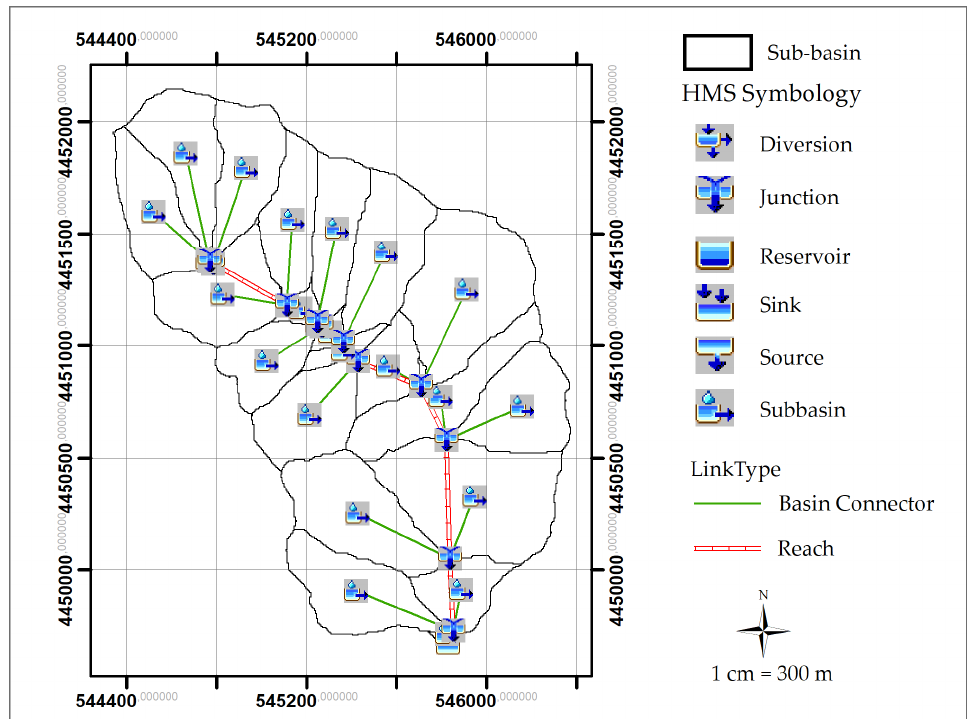
Figure 6. Ciciriello catchment divided into sub-basins for the distributed simulation. On the basis of the map in Figure 6, the geometric parameters for the sub-catchment and the relative river network were made available and suitable for the tc calculations by assuming Equation (3). In Table 6, the results for the time of concentration calculated with Equation (3) are reported for each sub-basin.